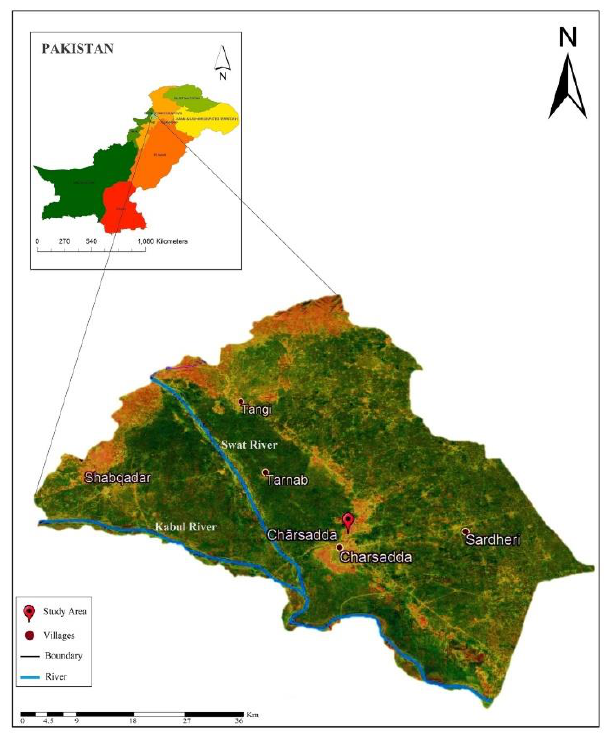
Figure 1: Location map of district Charsadda showing the extent of Kabul and Swat River. (The base map adapts from © Google